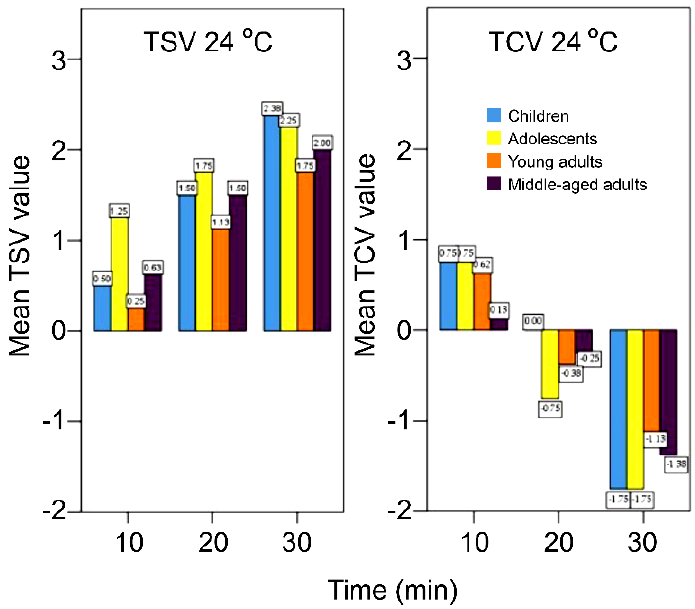
Figure 12. Comparison of the mean TSV and TCV of participants (24 °C).